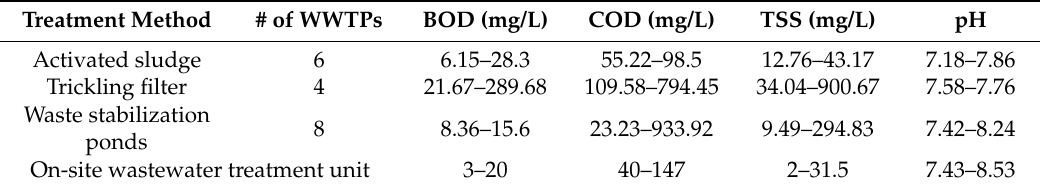
Table 2. Characteristics of some of wastewater treatment plants (WWTPs) and their operation conditions for the year 2014 [36], and characteristics of the on-site wastewater treatment unit at Water, Energy & Environment Center